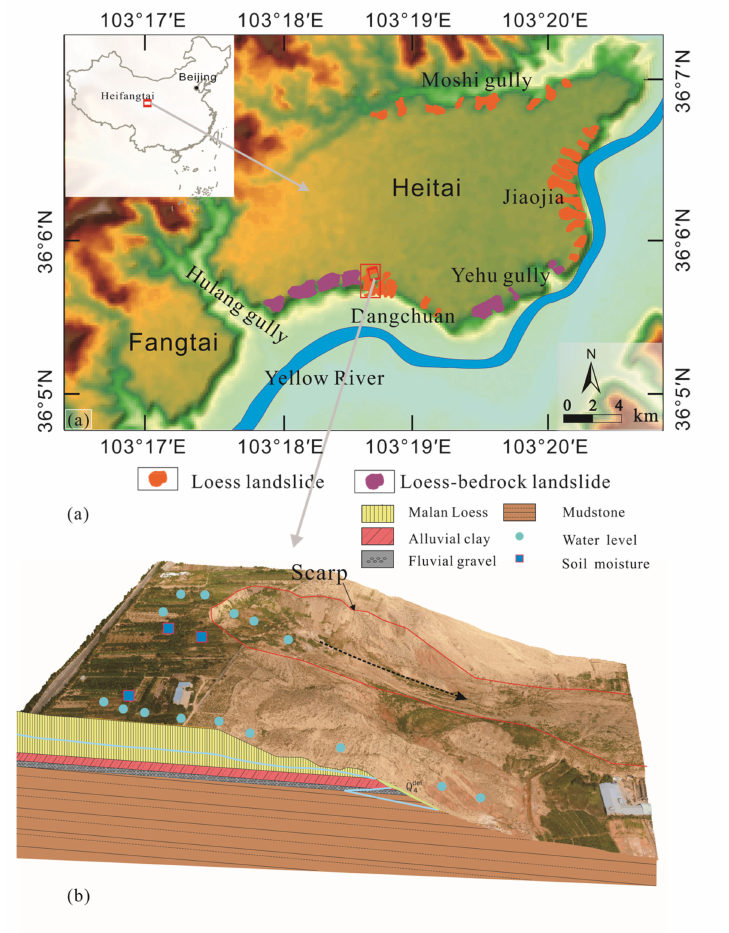
Figure 1. ( a ) Study area; ( b ) interpretative diagram of the lithological profile of the Dangchuan landslide cluster and site-monitoring